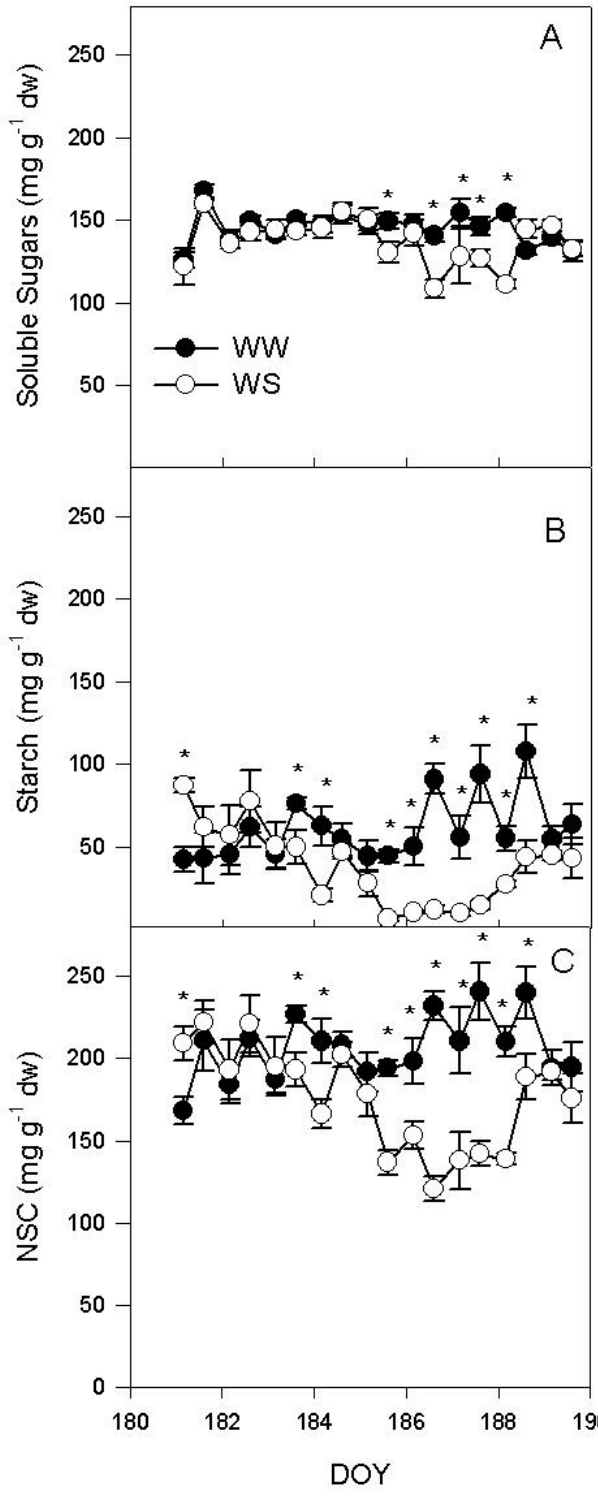
Figure 3. ( A ) soluble sugars, ( B ) starch and ( C ) non-structural carbohydrates (NSC) measured on mature leaves of well-watered (WW) and water stressed vines (WS) during the experiment. Each point is the mean of six vines ± SE. Points marked by asterisk are different per p < 0.05 ( t